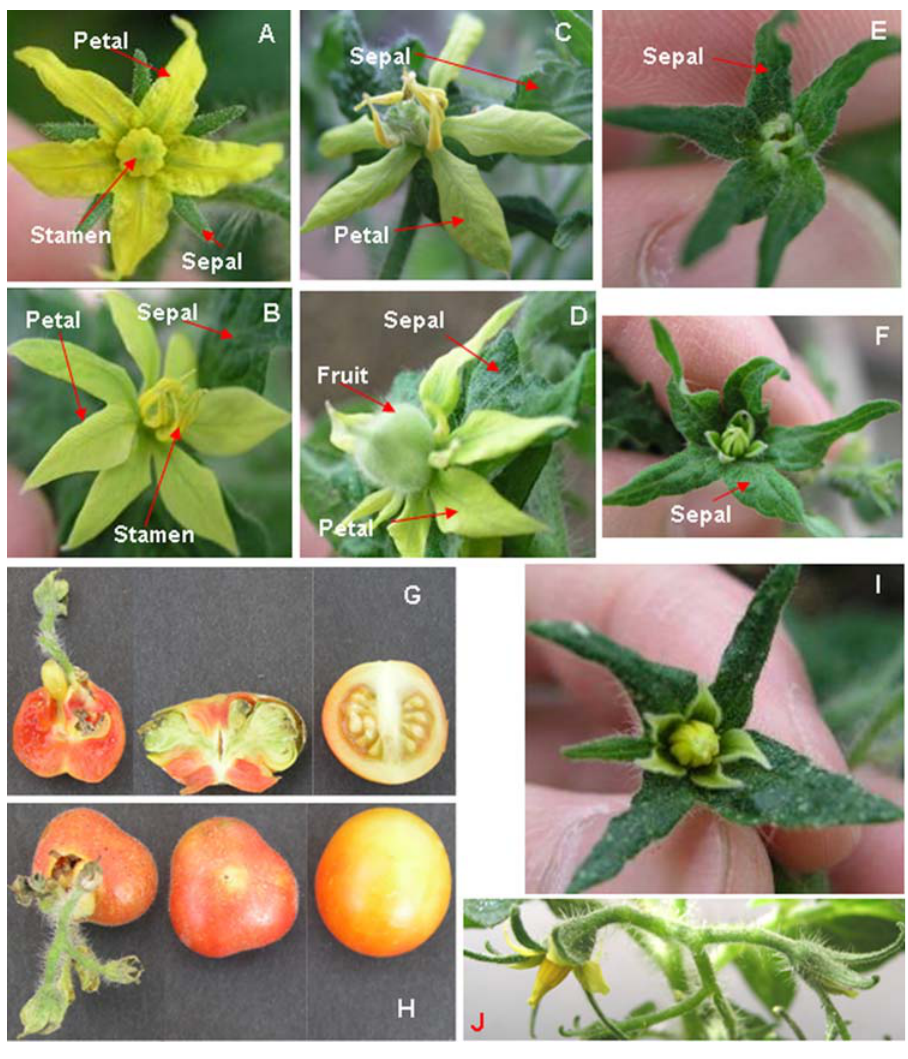
Figure 1. Late flowers from LS1 (B, C), LS3 (D), early flowers from LS1 (E), LS3 (F) and wild type Micro-Tina (A). These are late flowers that set parthenocarpic fruits ( C and D ). There were only 1–3 such flowers in each mutant. All other flowers are small and never develop large petals although they do have enlarged sepals. Vascular veins on the petals show a different pattern than the wild type as well. G–H : LS1 (left and center) and wild type (right) fruits. A shoot with flower buds grows out of one fruit (right). I–J : A control mutant showing slightly enlarged